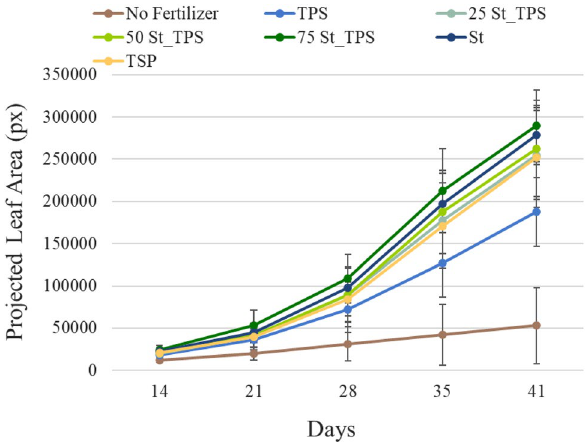
Figure 6. Trends of projected leaf area of each treatment over time. Bars show mean values ± standard deviations (n =